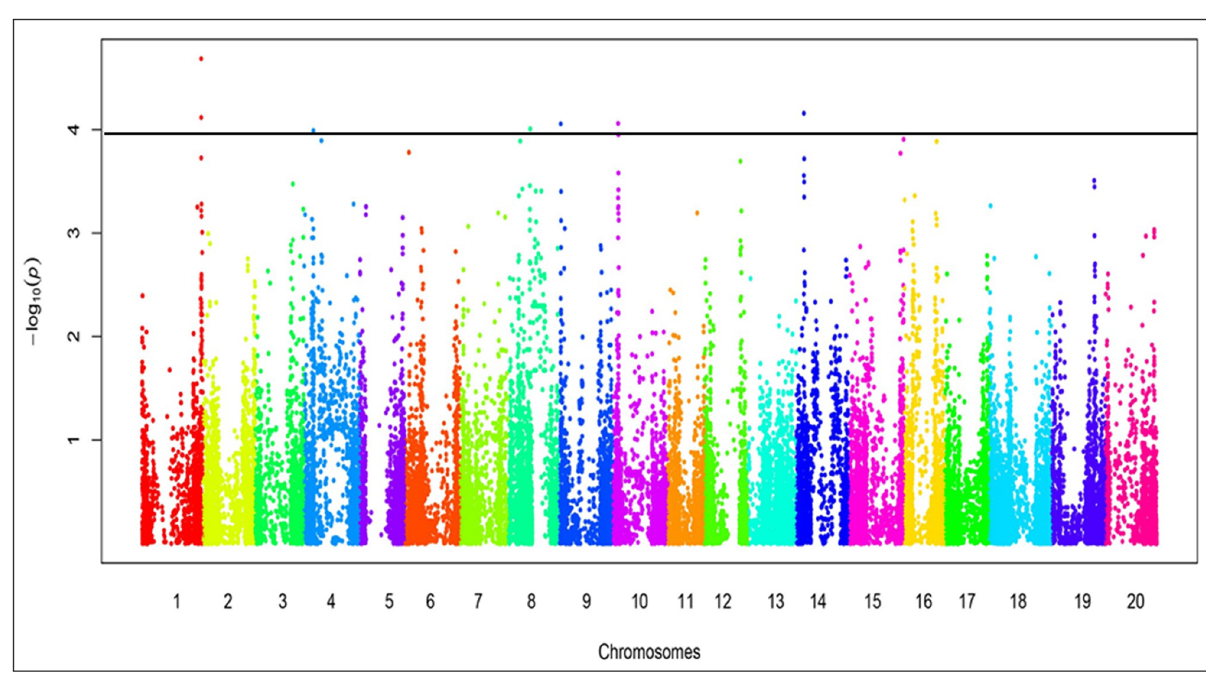
Fig 5. Manhattan plot of the SNPs associated with the root rot severities of 254 PI lines. The − log10 p -values from a genome-wide scan are plotted against the positions of each of the SNPs on 20 chromosomes. The horizontal blue line indicates the genome-wide significance threshold (FDR < 0.05). SNPs in Manhattan plot were placed in kb